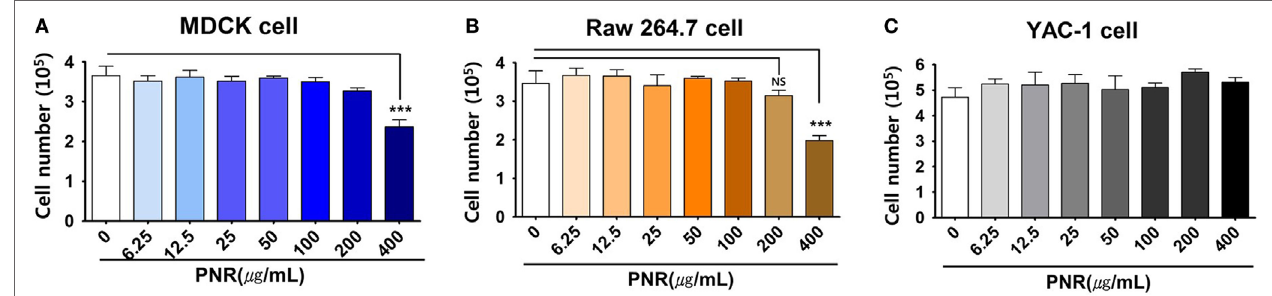
FigUre 2 | Determination of the cytotoxicity of Panax notoginseng (PNR) water extract in MDCK (a) , RAW 264.7 (B) and YAC-1 (c) cells. The viability of RAW 264.7, YAC-1, and MDCK cells was assessed using trypan blue exclusion analysis after 24 h of treatment with PNR at the indicated concentrations. Data represent the mean ± SEM of three independent experiments. Statistical significance between values obtained for PNR-treated and PNR-untreated cells were determined using Chi-square test, *** P < 0.001; n.s., not